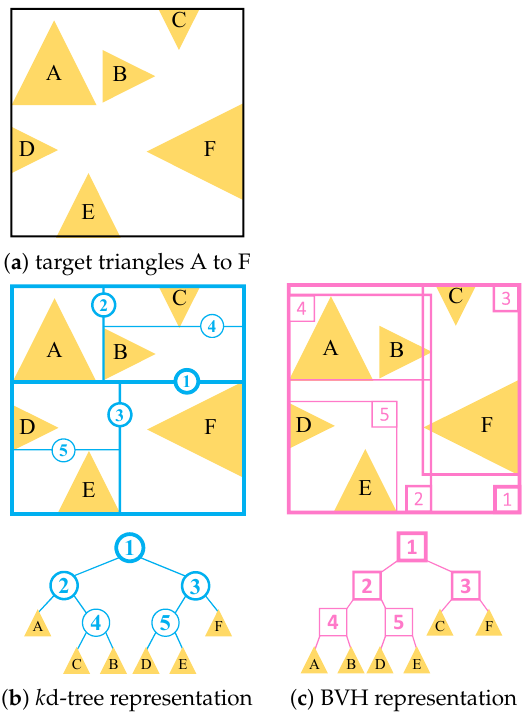
Figure 4. Visualization of two major acceleration